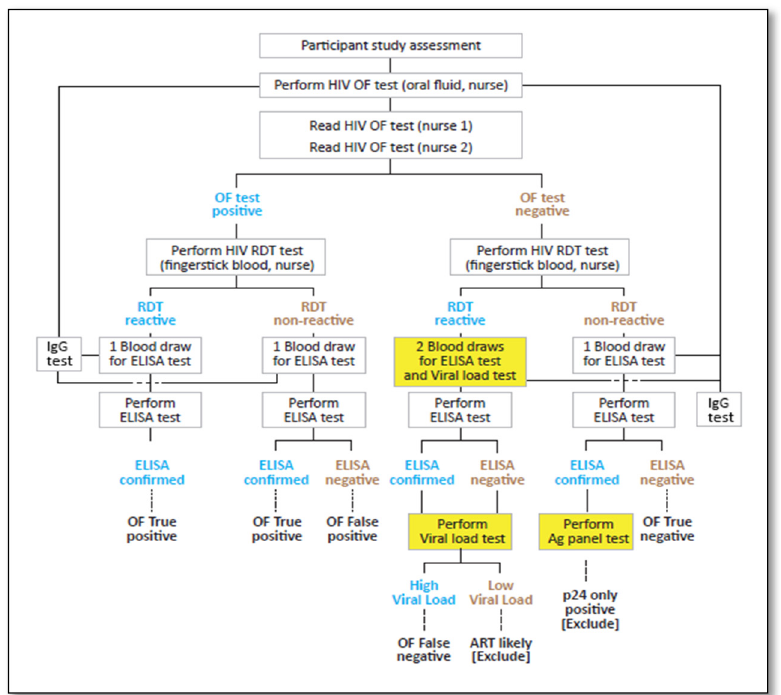
Figure A2. Asante™ HIV-1/2 Oral self-test used in Senegal.